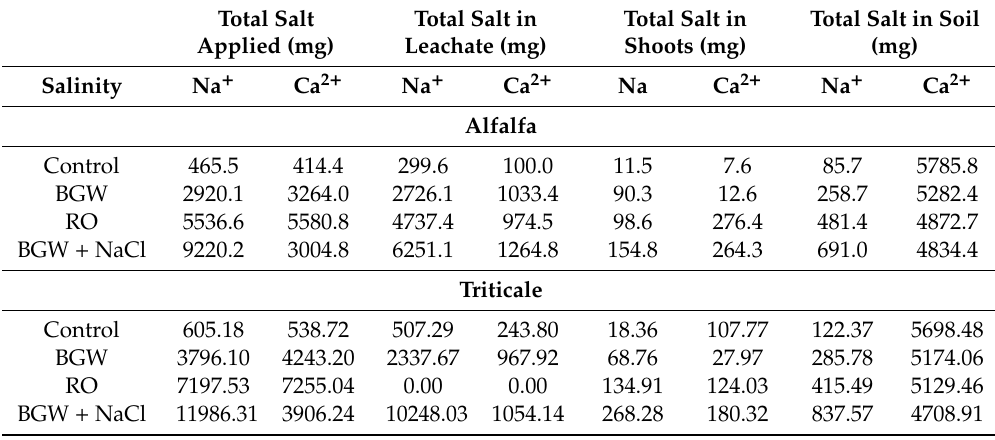
Table 5. Mass balance for Na + and Ca 2 + ions in the irrigation water (control with EC < 0.7 dSm − 1